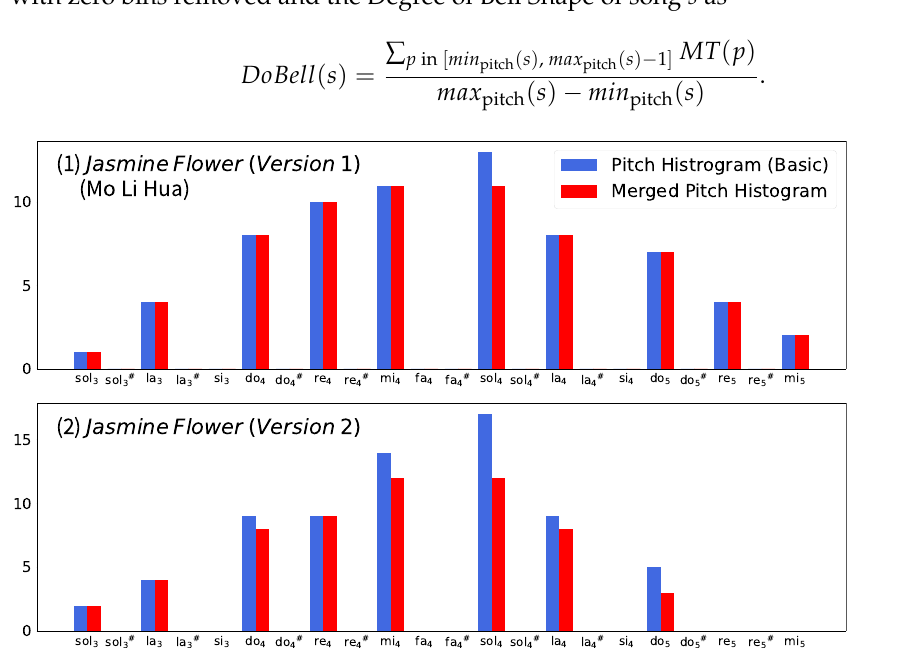
Figure 1. The movable do solfège-based basic pitch histograms and merged pitch histograms for the two versions of Jasmine Flower . (1) “Hao yi duo mo li hua”; (2) “Hao yi duo mei li de mo li